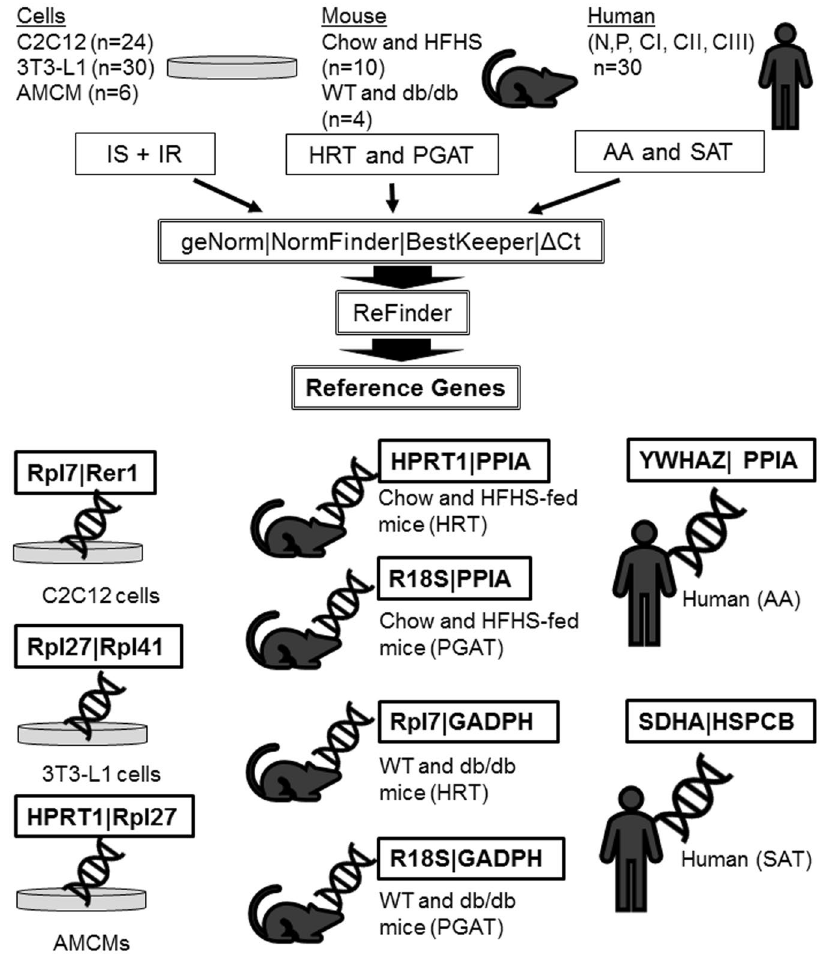
Figure 3. Schematic representation of the summarized results of the current study. Number and type of samples used, biological models, human patient classification, algorithms used and best two RGs selected for each biological model are